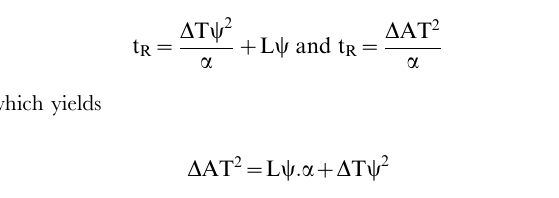
Figure 1. Theoretical analysis of nociceptive responses to heating. In this and the forthcoming Figures, the measurable variables are indicated with a yellow background while variables to be determined are indicated with a blue background. Individual curves of interest are shown in brown. Symbols, Abbreviations and Units can be found in table 1 . The psychophysical response R results mainly from a serial processing along the dedicated pathways involving successive time epochs. As proposed by Luce [12], we will reserve the term latency (L) to an unobserved hypothetical time. - A When skin is exposed to a constant source of radiant heat, the temperature T increases with the square root of time (left graph). It increases from the initial temperature T 0 to the AT value, reached at the time of the reaction, according to the law of physics T=f(t)=T 0 + a * t 0.5 . By definition, the duration of this process is t R , the reaction time. Expressed in terms of squared temperature variations, this relationship becomes linear (right graph): [T(t) 2 T 0 )] 2 =a 2 * t= a .t. The time t R is organized sequentially in physical (L Q ), biophysical (L t ) and psychophysical (L y ) latencies. Following a period of heating (L Q ), heat is transduced by nociceptors into neuronal spikes (period L t ), which in turn are transmitted toward, and received by, the CNS. Lp is the transit time for these spikes to reach the CNS. Ld is the ‘‘decision’’ time required by the CNS for interpreting and processing this information for an order to be sent to the motor system. Lm is the time required for a motor response to be triggered. L Q is completely dependent upon the heating rate and varies according to the experimental protocol. The other latencies are biological variables with L t % Lp [13–15], Lm % Ld [17] and L y =Lp + Ld + Lm. Four quantities are potentially accessible to experimental measurements: T 0 , AT, t R and a . - B Temporal evolution of the temperature of the skin during the application of thermal stimuli of various intensities. The stimulus is applied from time 0 till the response R of the subject. If one varies the power source of radiation, a series of measures can be made, including the heating of the skin from the initial temperature T 0 up to the apparent threshold AT (left graph). The relationship AT=f(t R ) (green curve) is an hyperbolic function with t=L y and T=T y as vertical and horizontal asymptotes respectively. In terms of squared temperature variations (right graph), the relationships are linear and the constant term a , slope of the straight lines, can be calculated. This term reflects the density of power of the heating source. The relationship D AT 2 =f(t R ) (green curve) is an hyperbolic function with t=L y and D T 2 = D T y 2 as vertical and horizontal asymptotes respectively. - B ’ One can modify the representation by adjusting the time scale of each individual curve for heating to the actual moment of the reaction. Such a change of origin allows one to visualize the back timing of events and to identify on the abscissa the point 2 L y and on the ordinate T y (left graph), or 2 L y and D T y 2 (right graph). Note that the latency artifact (AT 2 T y ) increases with the stimulus intensity. - C Corresponding D AT 2 =f( a ) relationship. The intercept and the slope of this linear function represent D T y 2 and L y , respectively. From D T y 2 , one can easily deduct the psychophysical threshold T y =T 0 + ( D T y 2 ) 0,5 . - D Representation of the linear function t R =f(1/ a )=L y + D T y 2 * (1/ a ). The intercept of the straight line with the ordinate gives the value of the psychophysical latency L y .